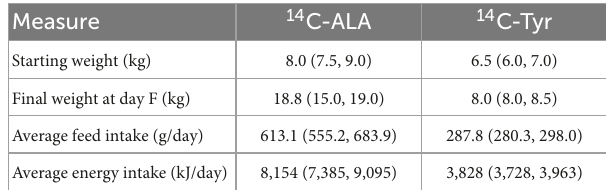
TABLE 1 Average body mass and feed intakes of pigs for each group ( n =